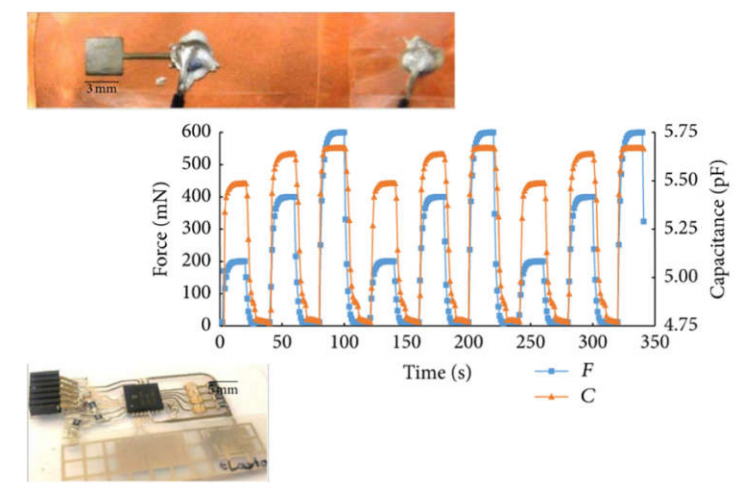
Figure 2. Dynamic response of the force sensor with 100 µ m polydimethylsiloxane (PDMS) thick from [86]. Insets: Upside—Picture of the fabricated sensor. Downside—Hybrid integrated system with inkjet-printed silver layers and PDMS force